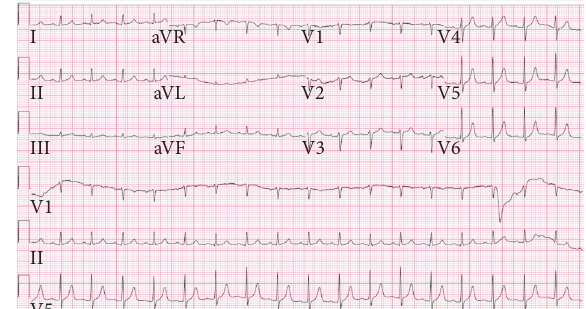
Figure 2: Showing resolution of Brugada pattern ECG changes after hyperkalemia was